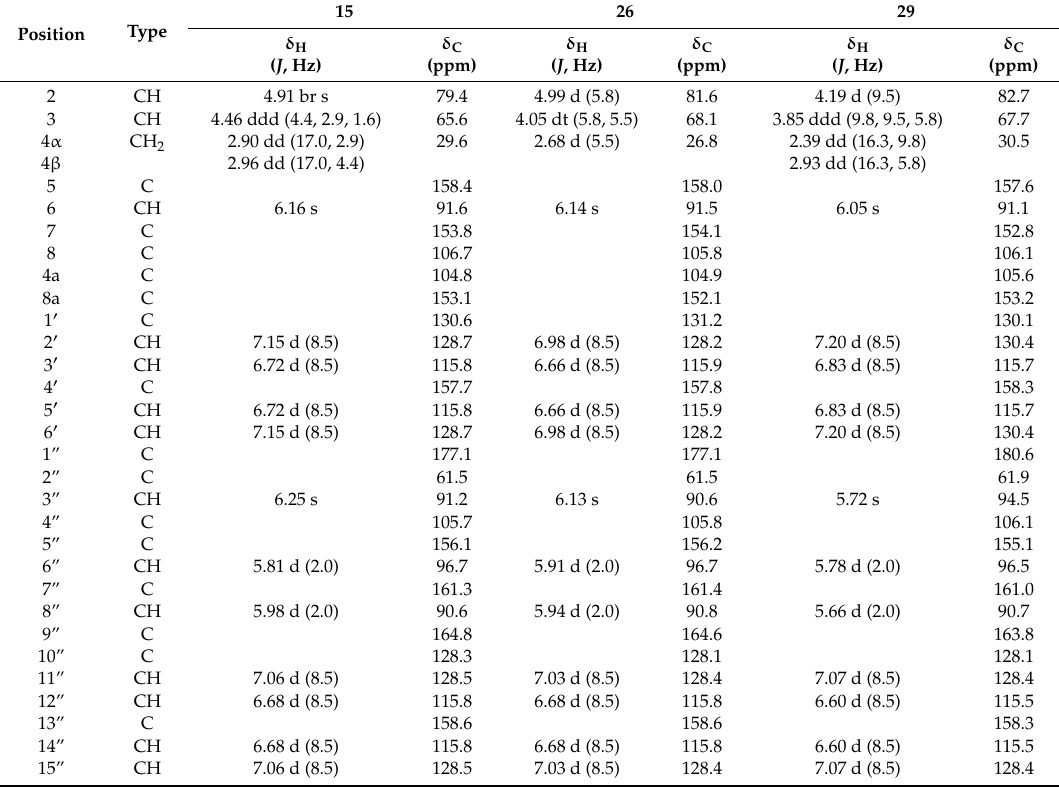
Table 2. 1 H and 13 C-NMR data (MeOH- d 4 , 500 / 125 MHz, 30 ◦ C) for compounds 15 , 26 , and 29 .